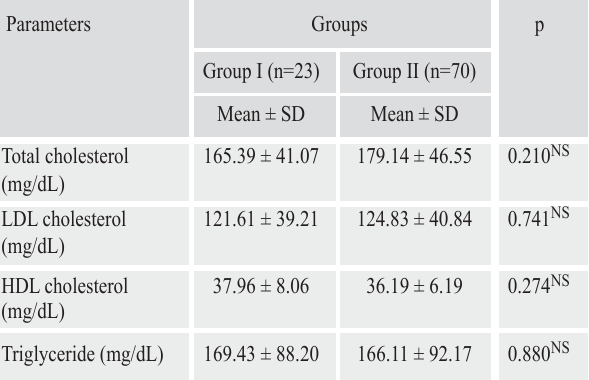
Table IV: Comparison of lipid profiles between two groups (N=93)